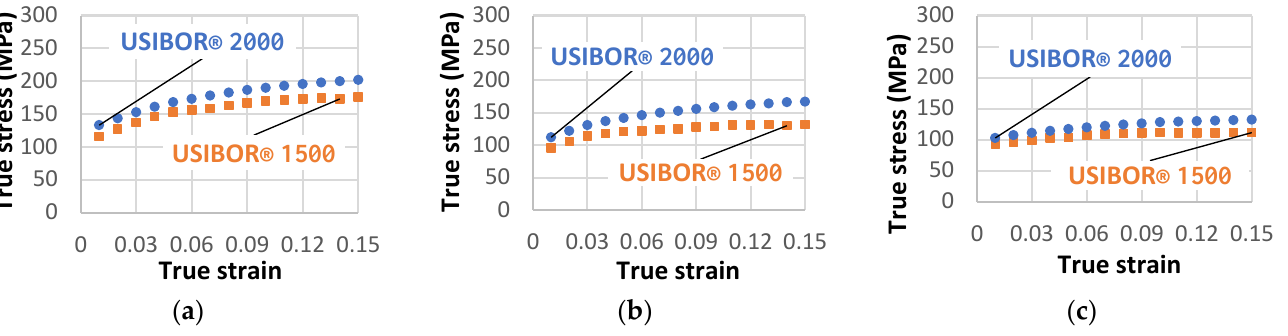
Figure 20. Comparison between the two investigated UHSS at the strain rate of 0.01 s − 1 and test temperatures of ( a ) 750 °C, ( b ) 800 °C and ( c ) 850 °C.